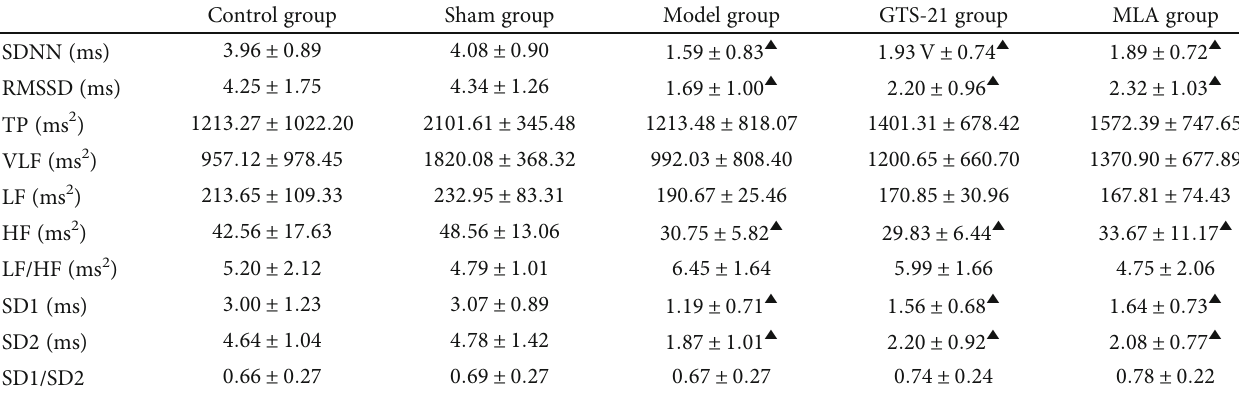
Table 2: Time and frequency domain and nonlinear analysis of HRV among di ff erent groups. Control group Sham group Model group GTS-21